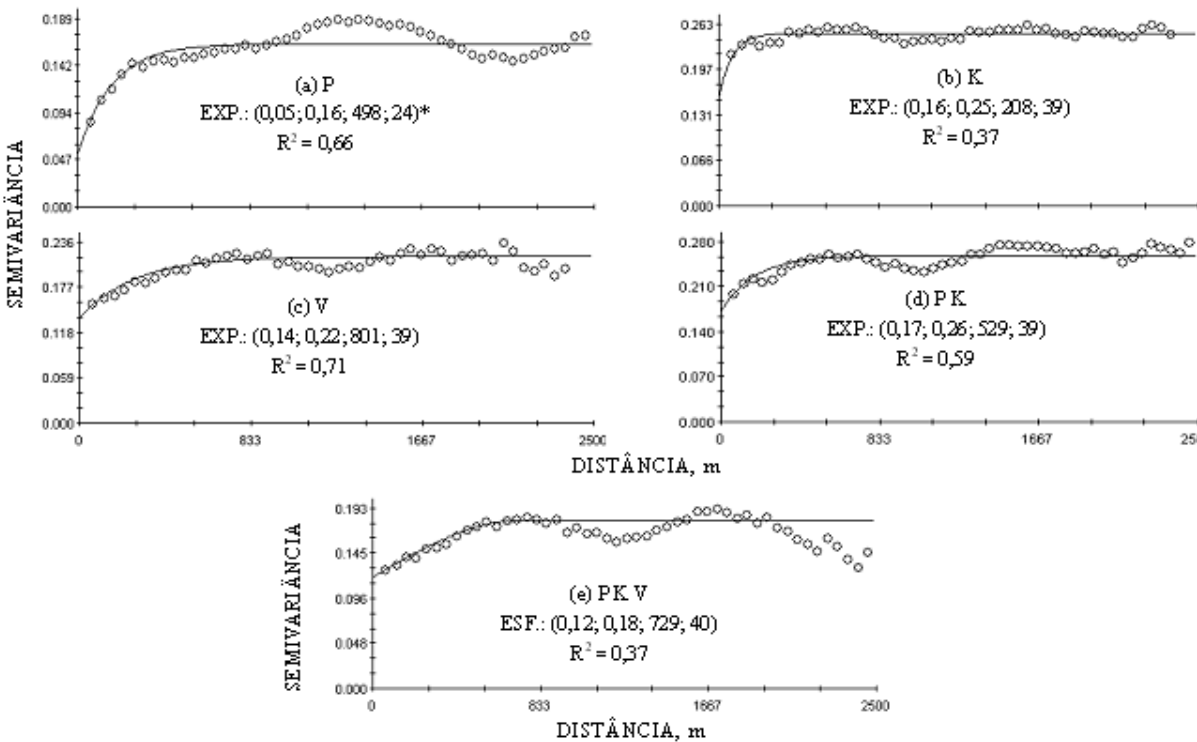
Figura 8. Semivariogramas das variáveis indicadoras, quando se utilizaram, como valores de corte, os níveis de fertilidade do solo para cana-de-açúcar no estado de São Paulo, propostos por Raij et al. (1996): (a) fósforo; (b) potássio; (c) saturação por bases (V); (d) combinação de P e K e (e) combinação de P K e V.